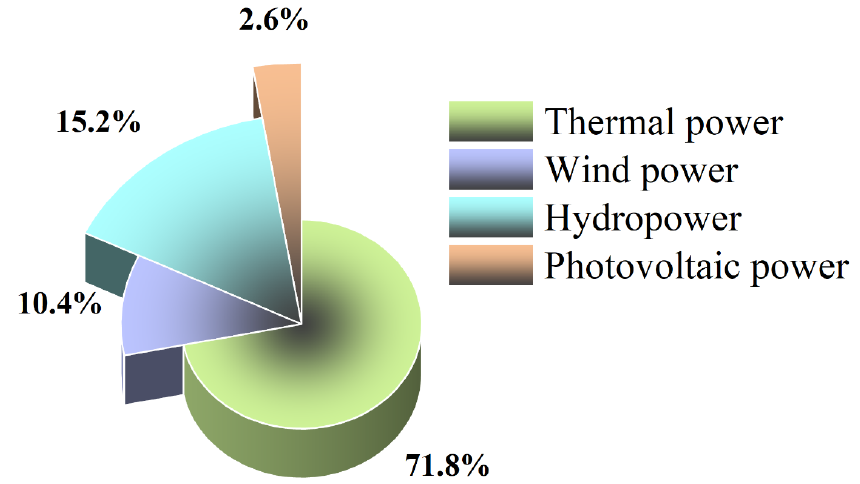
Figure 2. The proportion of hydropower in the total electricity generation of the five